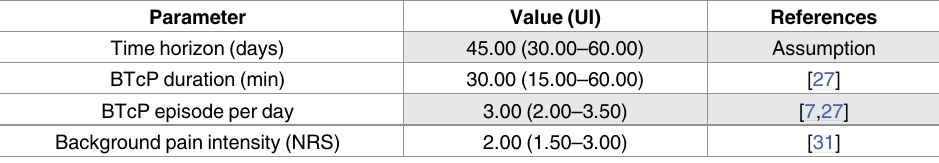
Table 1. Model parameters: Base case.